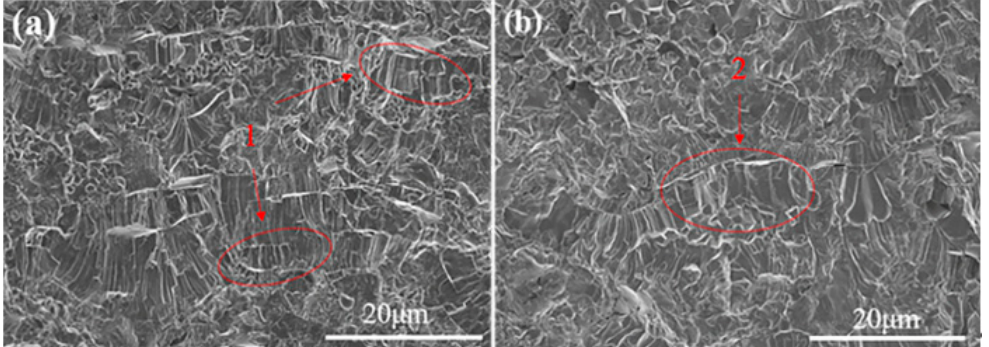
Figure 3. SEM micrographs of cross-sections of the coatings ( a ) N1 and ( b ) N4.